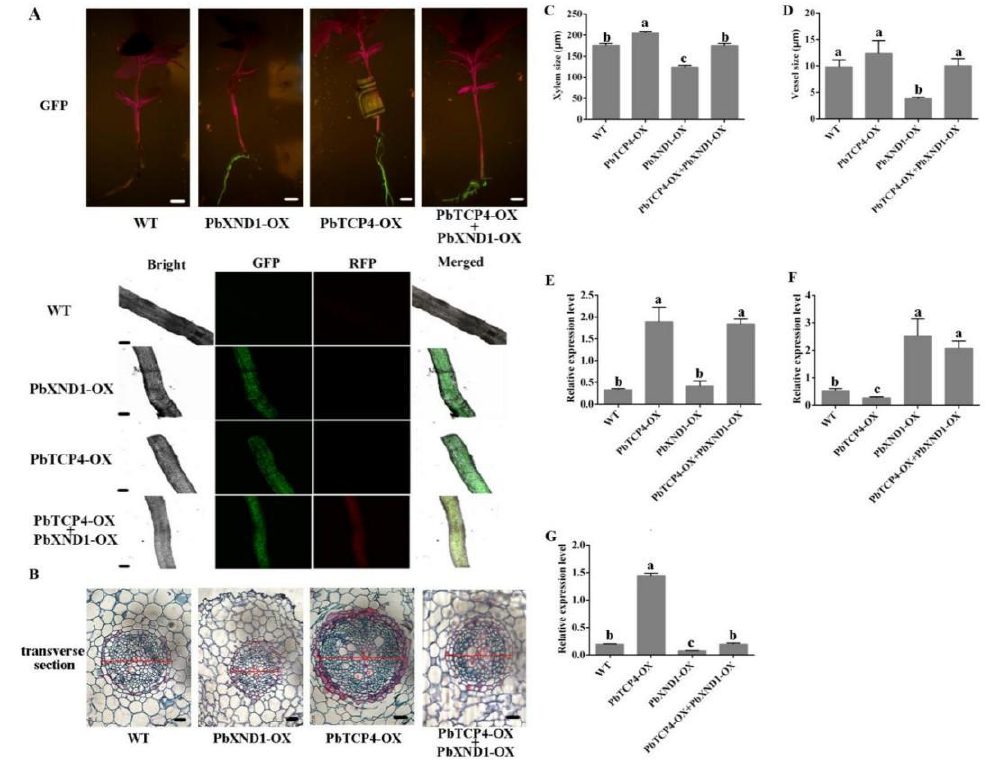
Figure 6. The xylem development was restored by overexpressing PbTCP4 in the PbXND1- overexpressed pear roots. ( A ) Fluorescence detection of transgenic pear roots. Bars, 1 cm and 50 µ m. ( B ) Transverse section observation of wild-type (WT), PbXND1-OX, PbTCP4-OX and co-expression roots (PbXND1-OX+PbTCP4-OX). X, xylem; V, vessel. Bars, 20 µ m. ( C ) Xylem size of pear roots. ( D ) Vessel size of pear roots. Data are shown as means ± SD ( n = 6). Different letters denote statistical significance ( p < 0.05). ( E – G ) Relative expression of PbTCP4, PbXND1 and PbVND7 in transgenic pear roots. Data are shown as means ± SD ( n = 3). Different letters denote statistical significance ( p < 0.05).